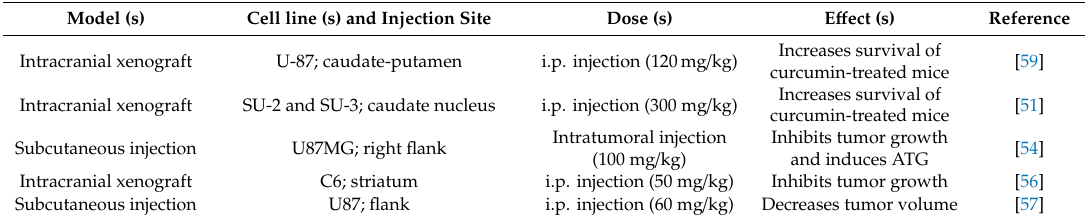
Table 2. In vivo anti-tumor e ff ects of curcumin on glioblastoma